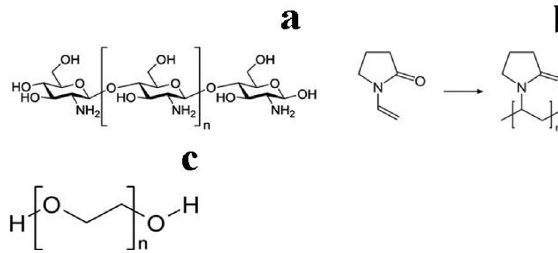
Figure 10: Chemical structure of (a) chitosan